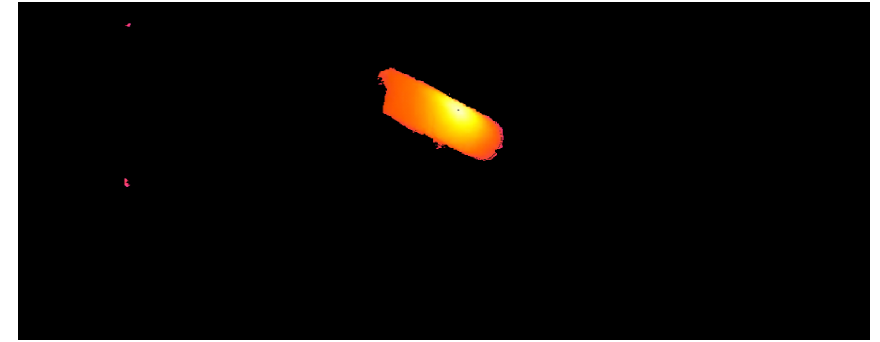
Figure 21. Segmented hotspot.